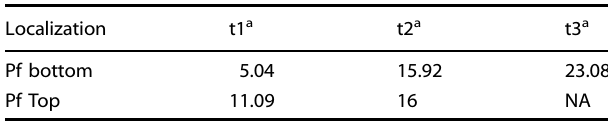
Fig. 5 Surface-dwelling characteristics of Bt and Pf in the channel: bottom vs. top surface colonization. Confocal fl uorescence intensities of a Bt and b Pf recorded with a focus on the bottom surface (light green ( a ) and light red ( b )) and on the top surface (dark green ( a ) and dark red ( b )). Axial resolutions are 5 and 5.8 µm for FAST and mCherry signals, respectively. c Confocal images recorded at time t = 3 h on the bottom surface (upper panels) and on the top surface (lower panels) for Bt (left panels) and Pf (right panels). The same experimental conditions were used as in Fig. 1. Table 2. Pf bottom vs. top surface